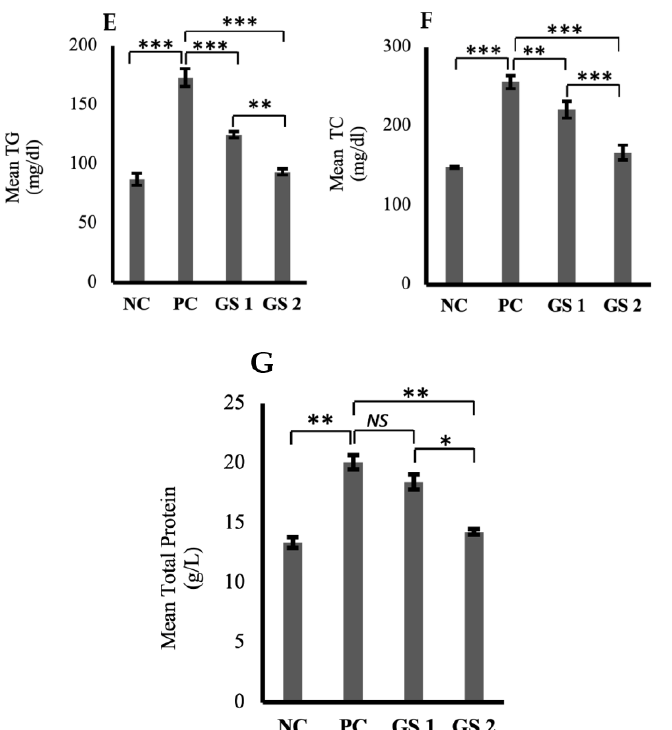
Figure 5. Mean plasma levels of high-density lipoprotein (HDL, mg/dl) ( A ), albumin (ALB, µg/mL) ( B ), low-density lipoproteins (LDL, mg/dl) ( C ), very low-density lipoprotein (VLDL, mg/dl) ( D ), triglycerides (TG, mmol/mL) ( E ), total cholesterol (TC, mg/dl) ( F ), total protein (TP, g/dl) ( G ) in different groups. Negative control (NC), positive control (PC), Gymnema sylvestre 250 mg (GS1), Gymnema sylvestre 500 mg (GS2). NS : non-significant, ( * ): p ≥ 0.05, ( ** ): p ≥ 0.01, ( *** ): p ≥ 0.001.